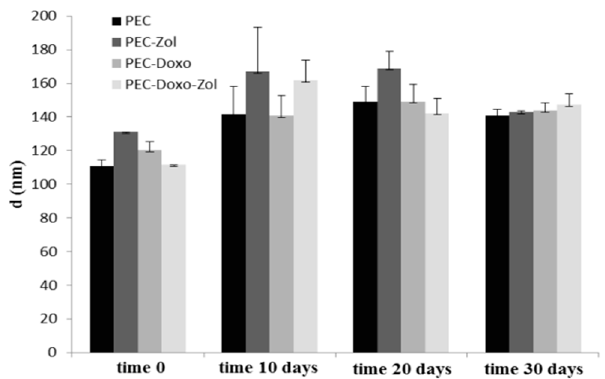
Figure 1. Size and PI of different PEC formulations as a function of time, in water at 4 °C.